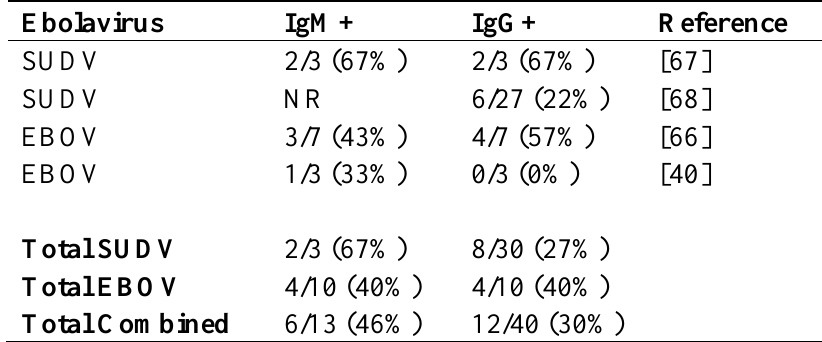
Table 1. Anti-ebolavirus antibodies in fatal human cases. The literature was surveyed for reports of anti-filovirus antibodies in the serum of lethally-infected human patients. Four studies were found, and are reported here. In each case, the lowest dilution of serum tested was 1:100. NR, not